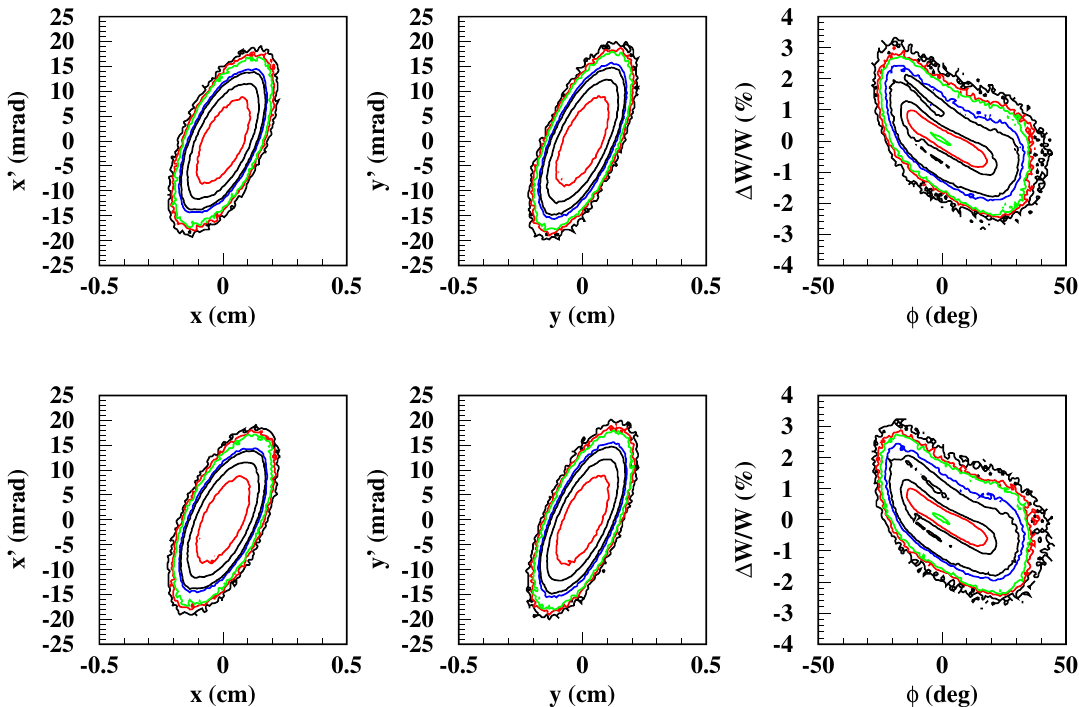
FIG. 10. (Color) Comparisons of simulation results between the serial and parallel versions of TRACK for a 325 MHz RFQ. 10 6 particles of H (cid:1) are accelerated from 50 keV to 2.5 MeV. The upper phase space plots are from the parallel code, and the lower ones are from the serial